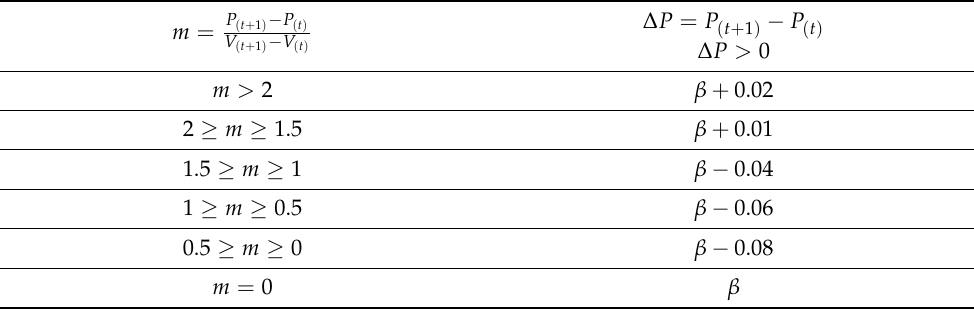
Table 4. The step change factor based on the slope of P–V curve for improved cuckoo